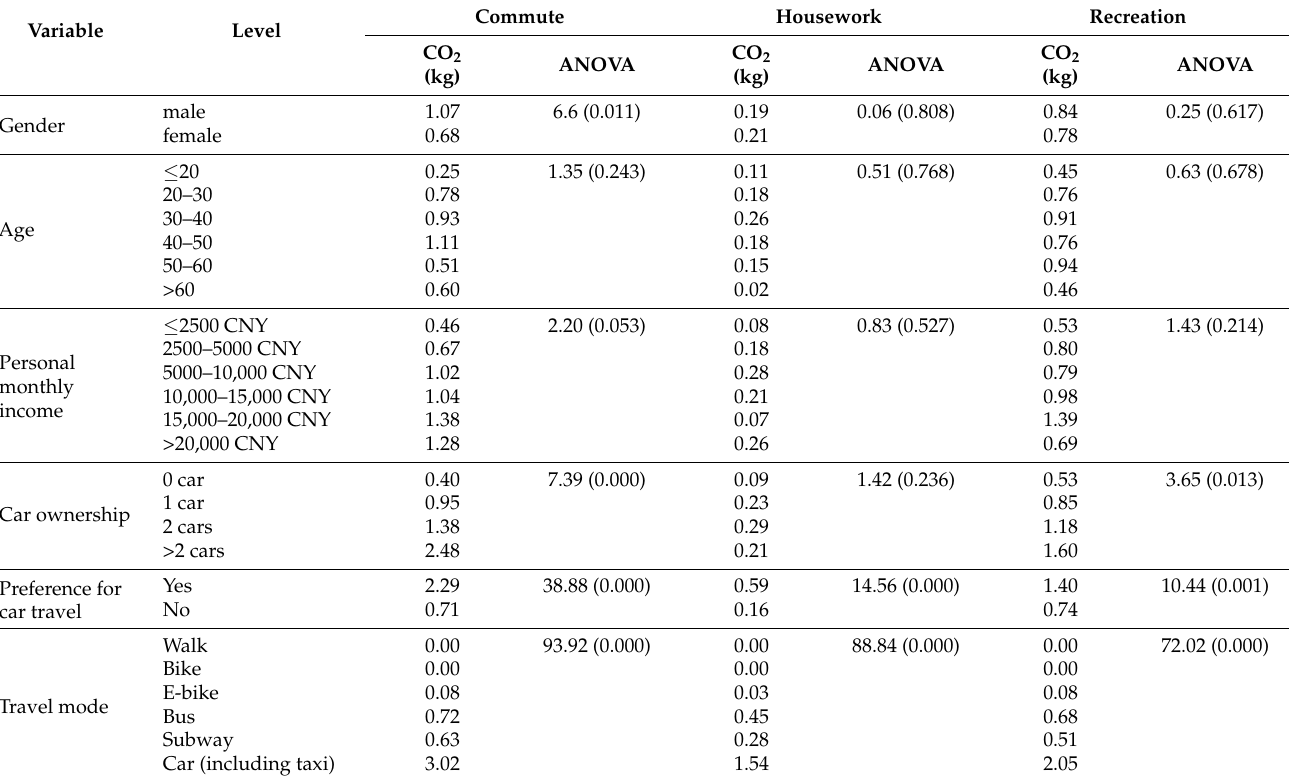
Table 4. Travel-related CO 2 emissions based on socioeconomic attributes and travel